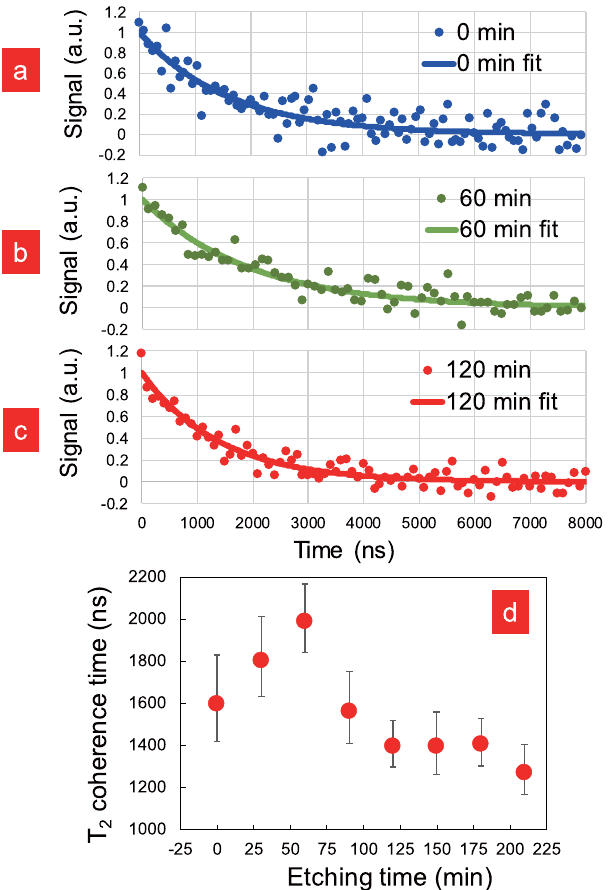
Figure 5. Normalized Hahn-echo signals (dots) before ( a ), after 60 min ( b ), and after 120 min ( c ) of NF etching, with exponential fitting curves (lines). ( d ) The measured Hahn-echo T 2 of the single-NV nanodiamond as a function of the NF etching